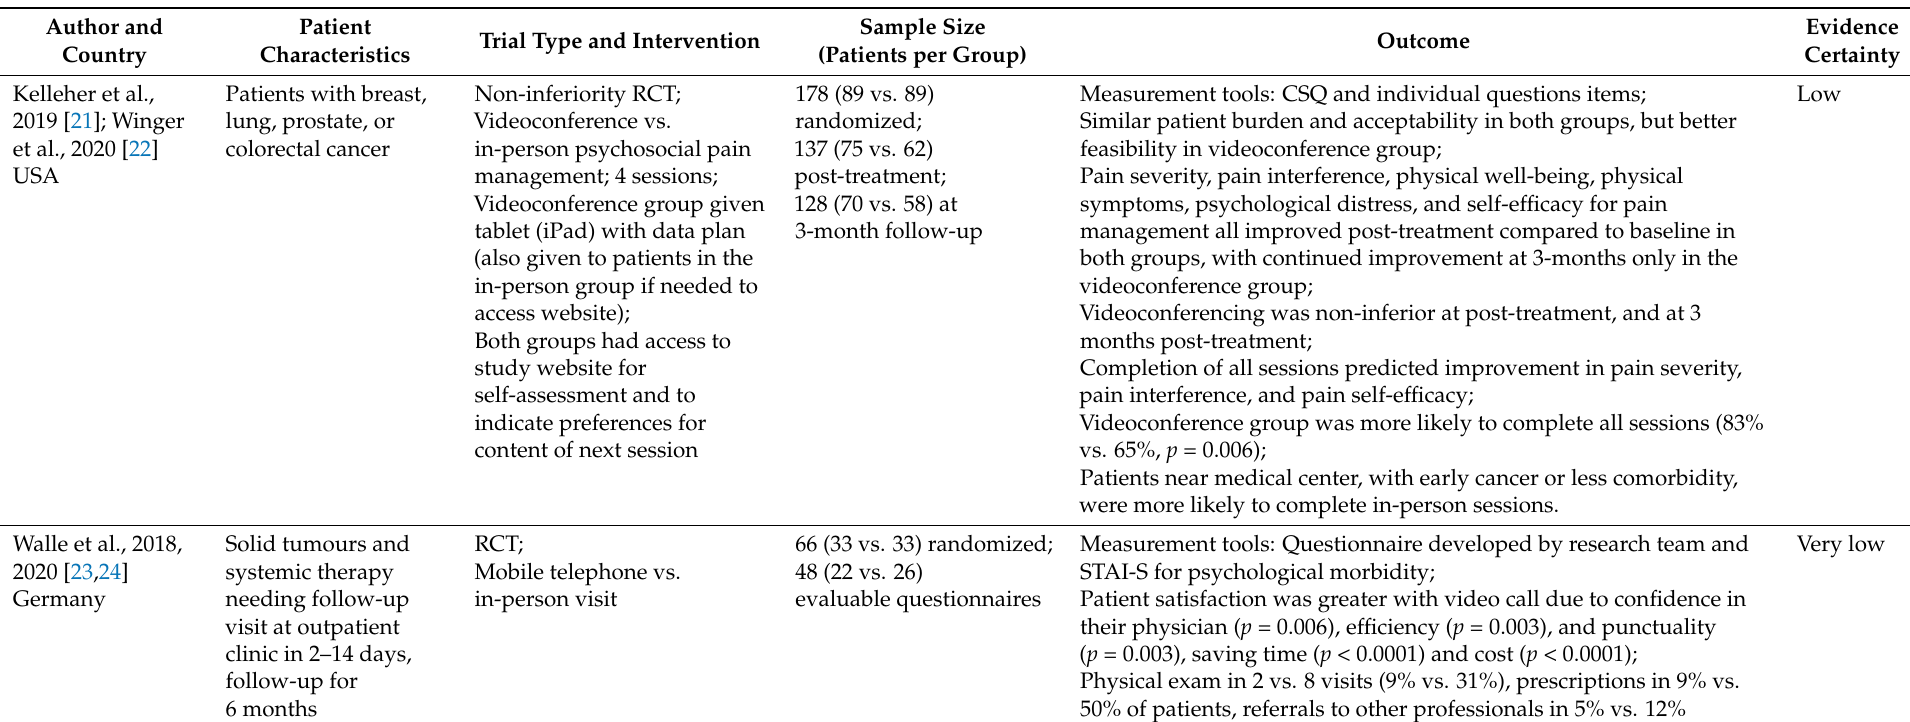
Table 2. Studies except